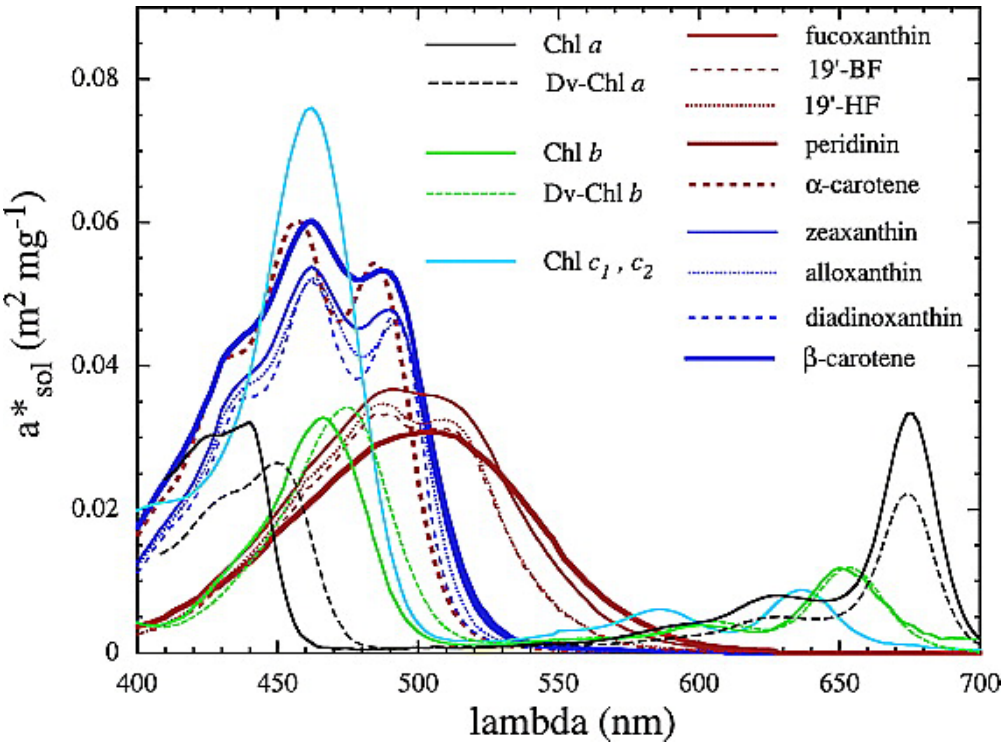
Figure A1. Pigment absorption spectra from Bricaud et al. [87], reprinted with permission from the American Geophysical Union. The broad featureless absorption spectra of fucoxanthin and peridinin peaking at around 500 nm are shown by the thin and thick brown lines,